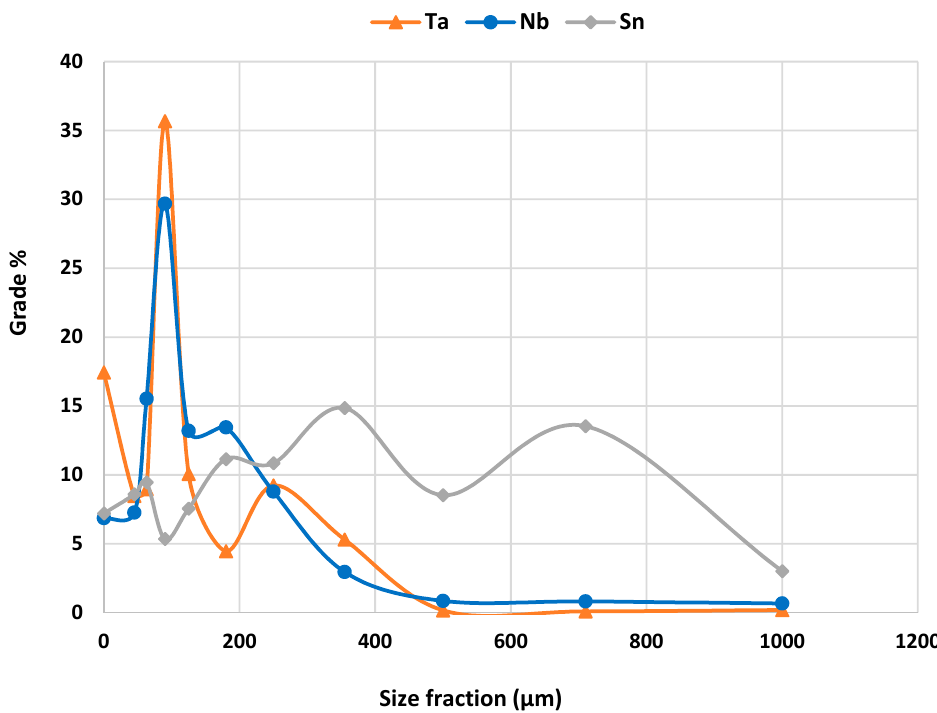
Figure 2. Size vs grade for HLS concentration. Figure 2. Size vs. grade for HLS